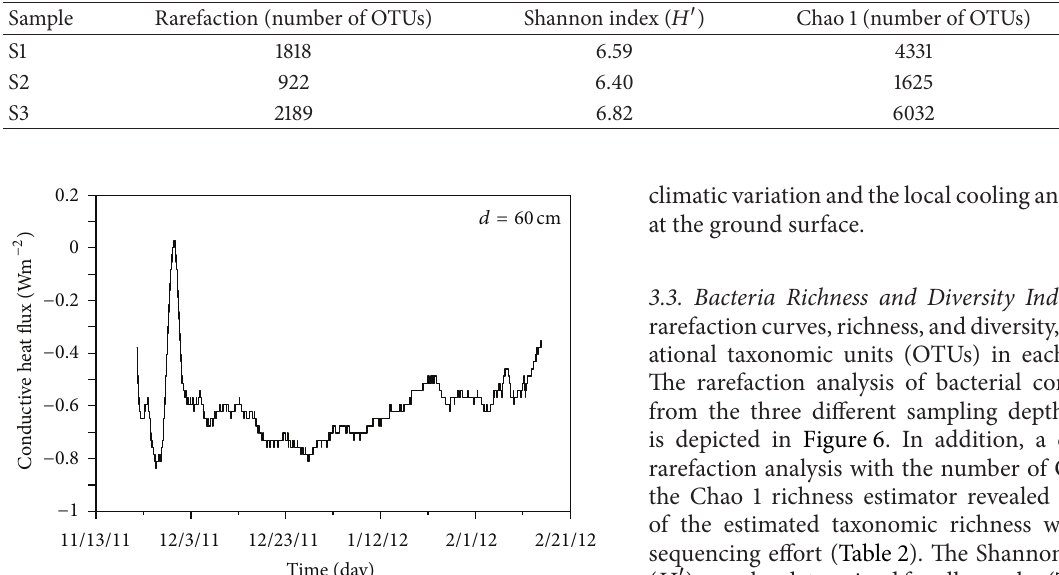
Table 2: Species richness estimates obtained from the soil samples.